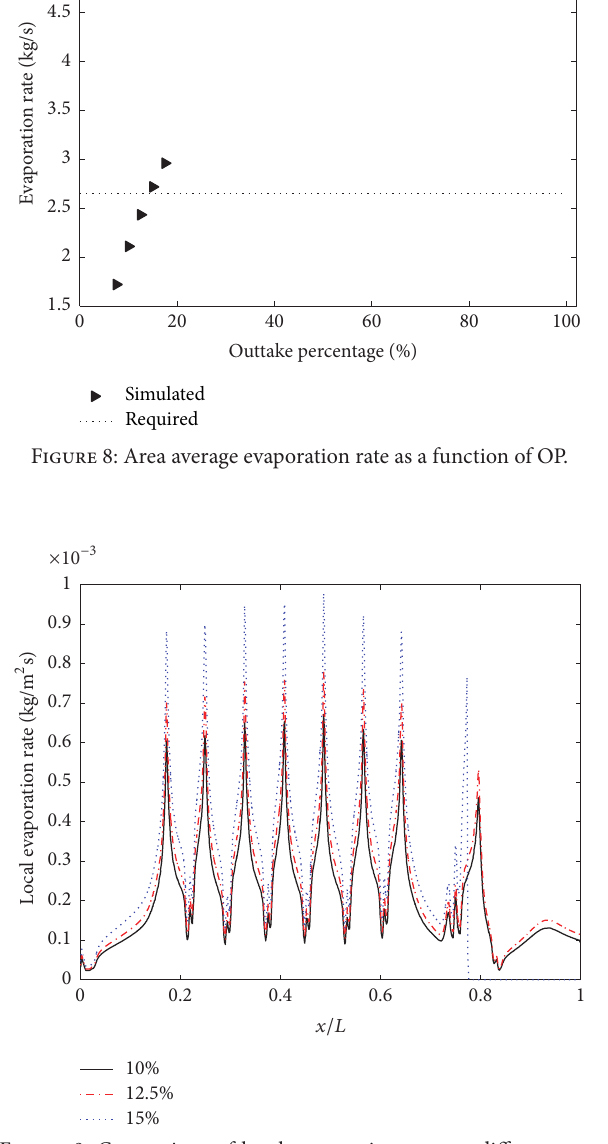
Figure 9: Comparison of local evaporation rates at different out- takes of moist air.